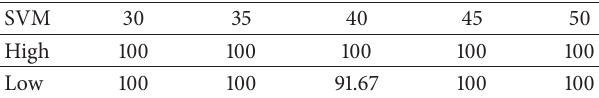
Table 8: The performance of SVM in both schemes when LOLO cross-validation is